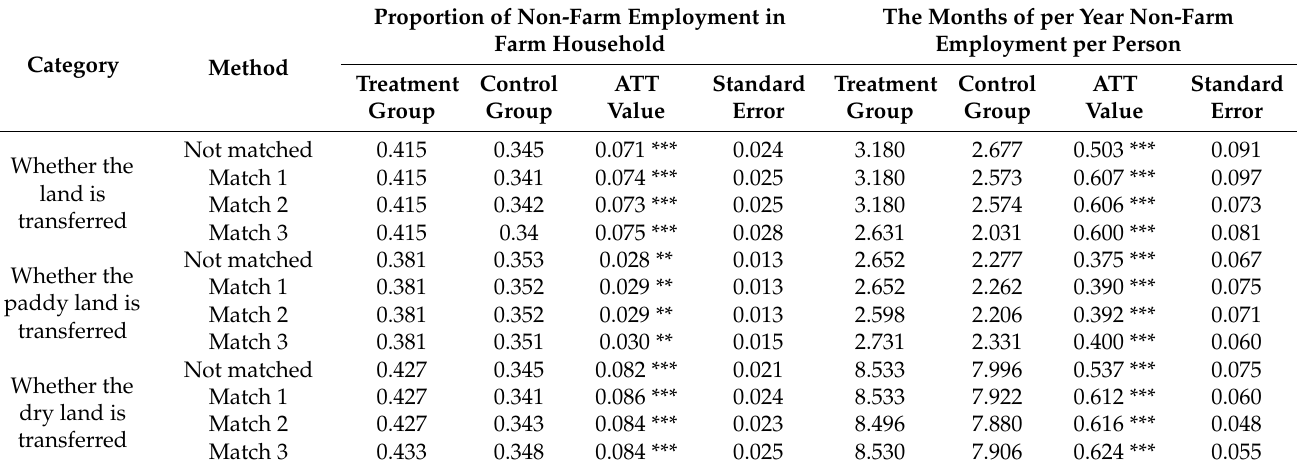
Table 3. PSM estimation of whether land is transferred on non-farm